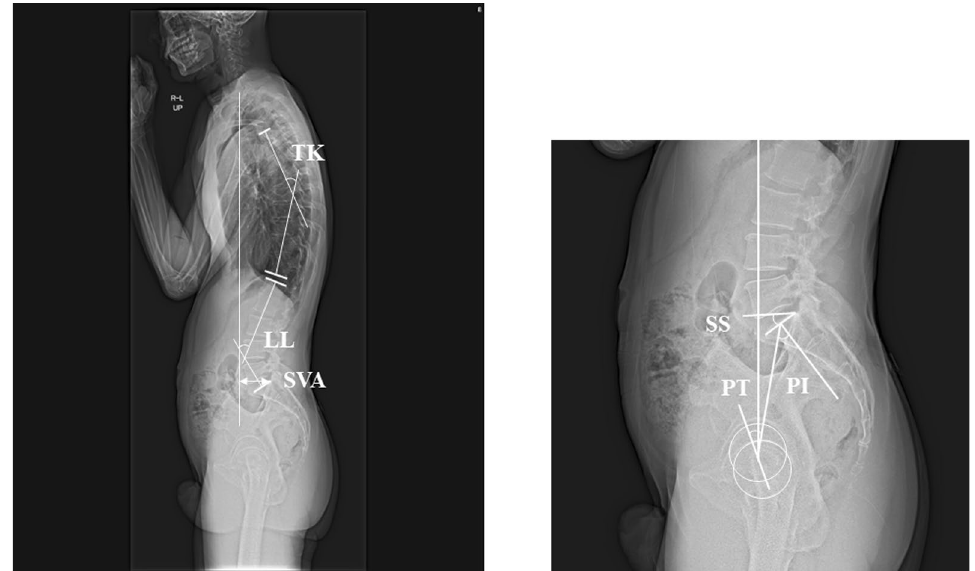
Fig. 1 Measurements of spinal parameters. The SVA was defined as the distance between the vertical line from the center of the seventh vertebral body and the posterior edge of the first sacral vertebra. TK was defined as the angle between the parallel lines drawn along the twelfth inferior thoracic vertebra and the fourth superior thoracic vertebra. LL was defined as the angle between the parallel lines drawn along the first superior lumbar and sacral vertebrae. SS was defined as the angle between the horizontal line and first superior sacral vertebra. PT was defined as the angle between the vertical line and the line connecting the centers of the bilateral femoral heads. PI was defined as the angle between the vertical line from the superior first sacral vertebra and the line connecting the centers of the bilateral femoral heads. SVA sagittal vertical axis, TK